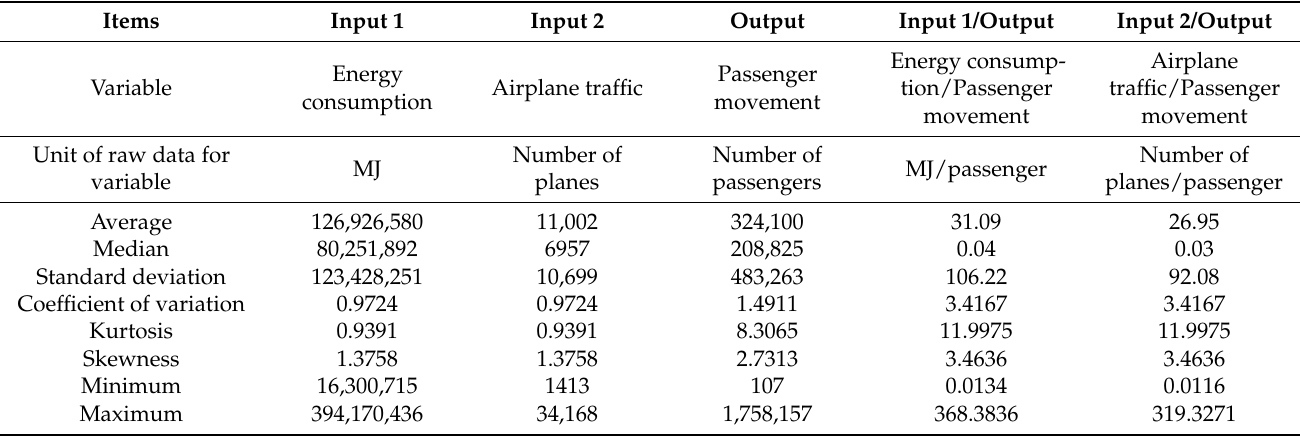
Table 2. Selected summary statistics for twelve Polish airports in 2019.